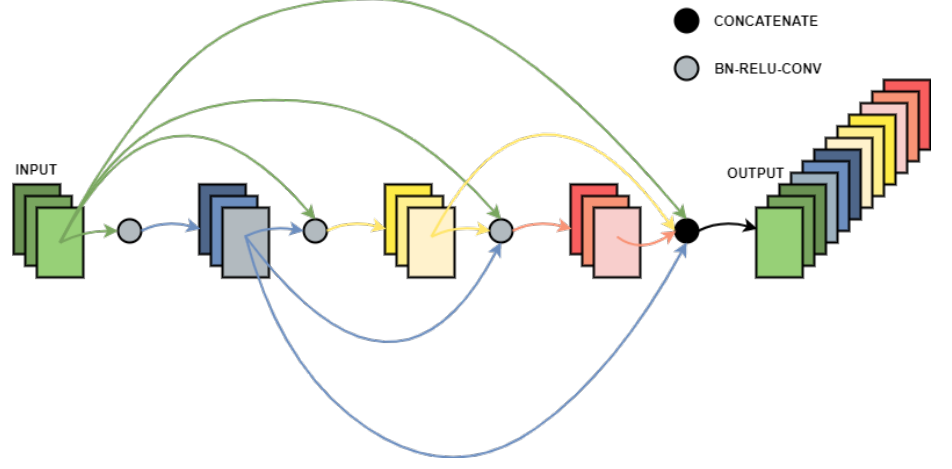
Figure 4. Densely concatenated convolution pattern